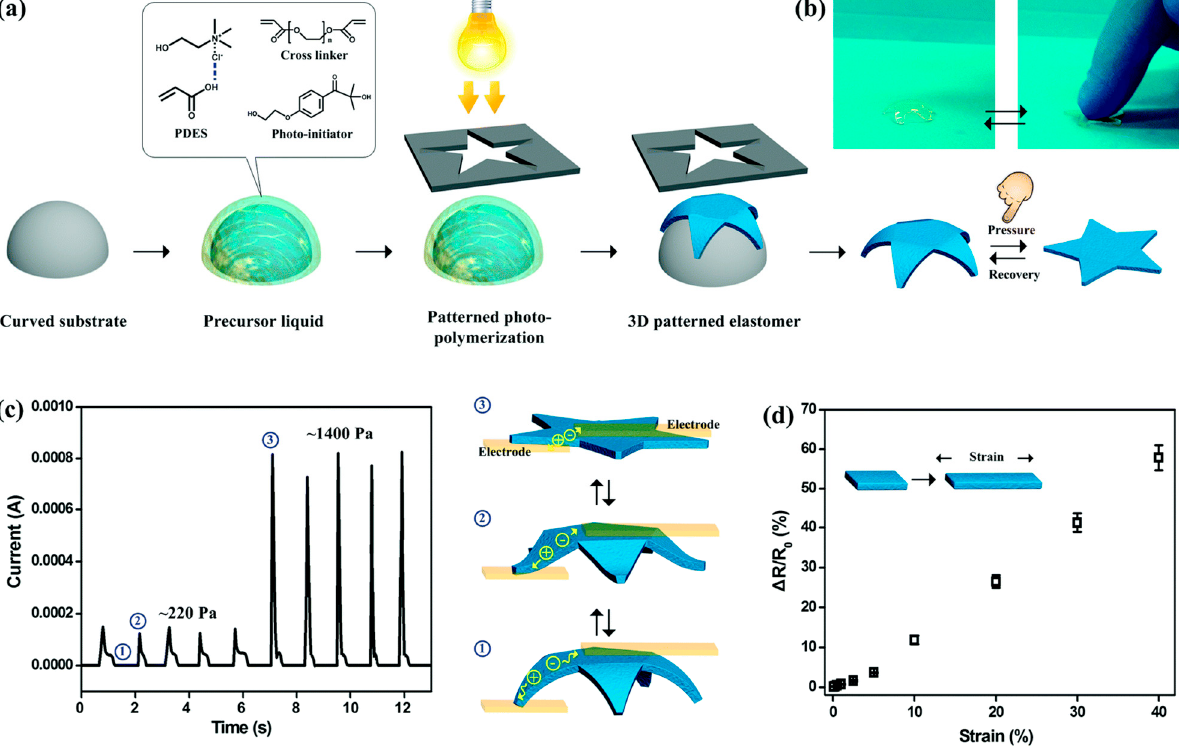
Figure 3. Printed tactile sensors based on AA:ChCl polymerizable eutectics (referred to as PDES in the Figure). ( a ) Overview of photopolymerization and patterning of AA:ChCl eutectic on curved substrates. ( b ) Images of the curved object being reversibly deformed under pressure. ( c ) Measured current through the printed object as a function of applied pressure at various deformation; ( d ) Strain–response plots for stretching the printed object. Reproduced from Ref. [68] with permission from The Royal Society of Chemistry, copyright 2017.